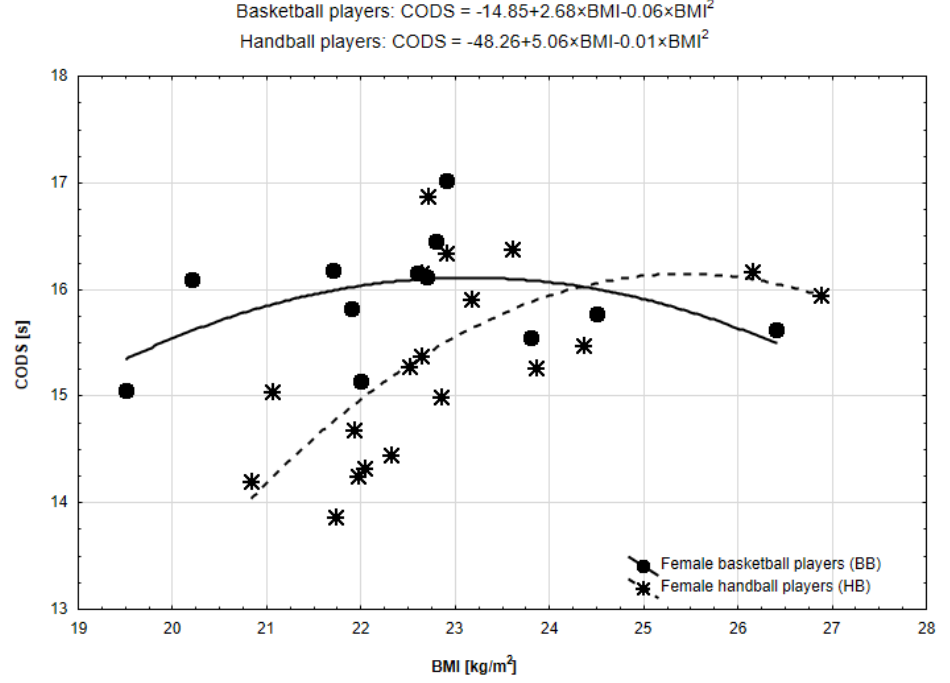
Figure 3. Functional forms of the relationships between BMI and CODS in BB and HB.